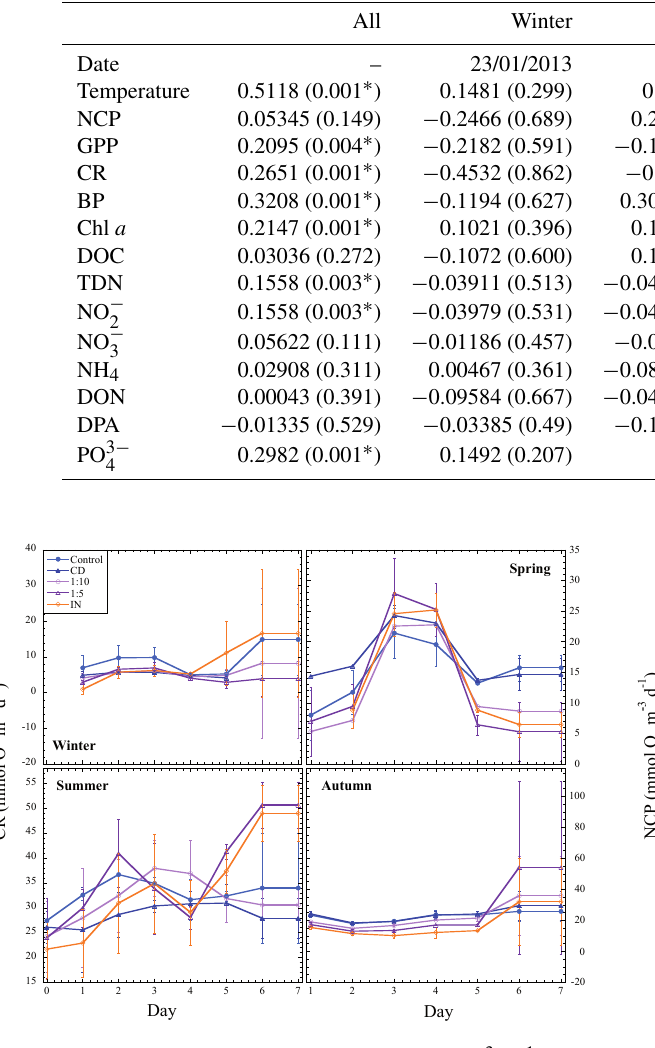
Figure 4. Community respiration (CR) in mmolO 2 m − 3 d − 1 mea- sured the seven incubation days for the different treatments and ex- periments.